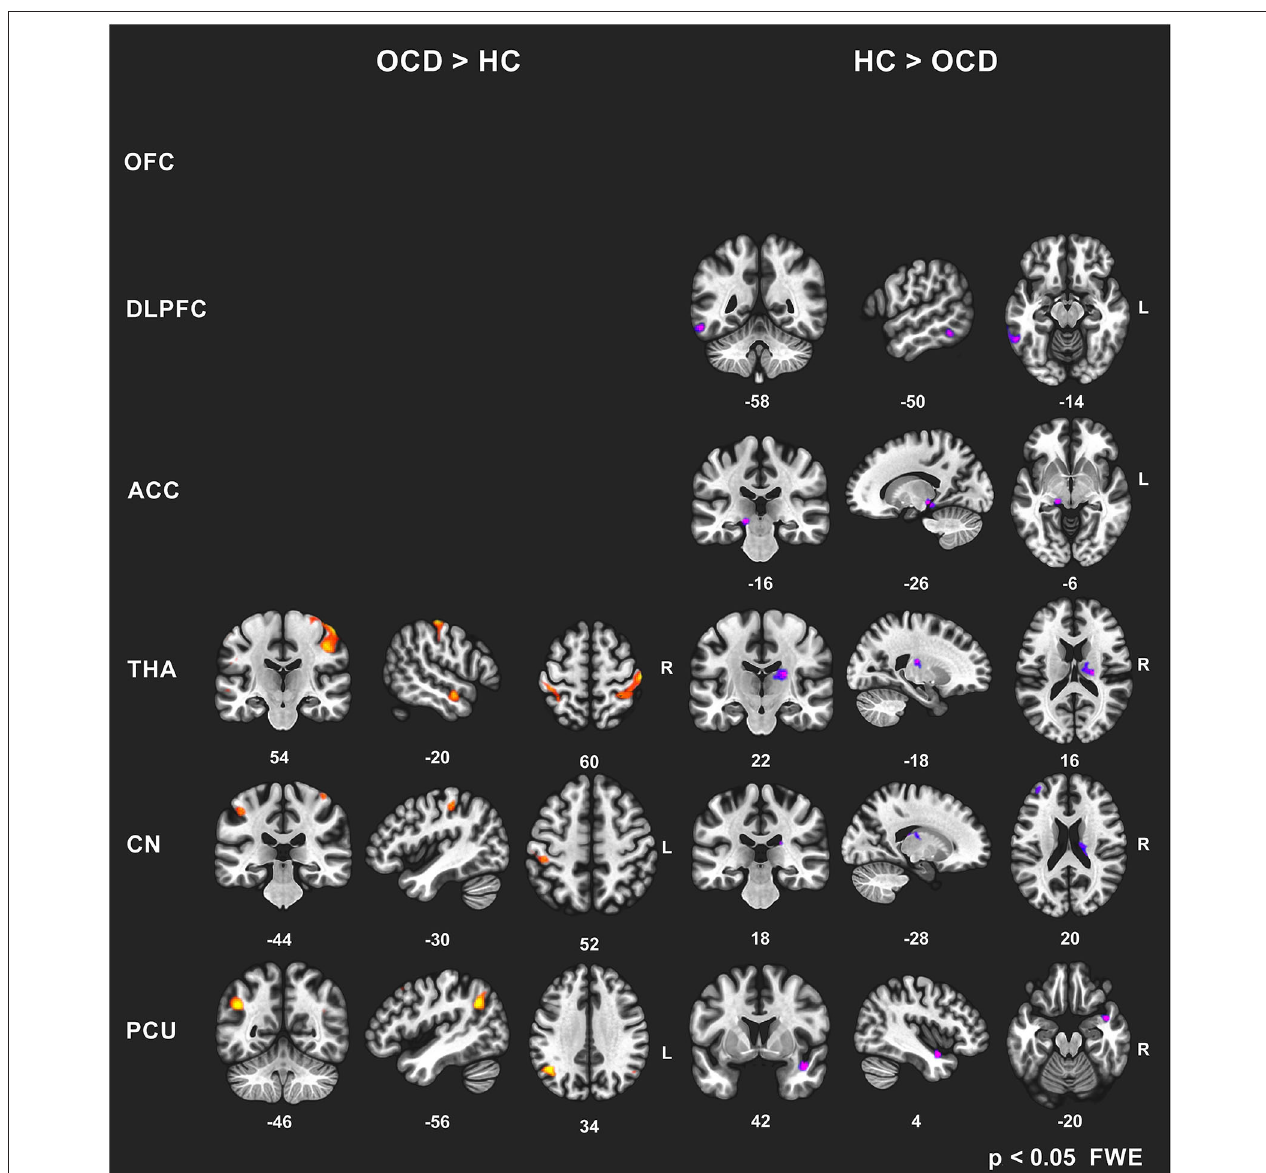
FIGURE 1 | Between-group comparisons of FC effects for individual seeds (brain slice display, FWE corr. p level 0.05, with cluster-forming threshold p < 0.001). Increased (OCD > HC) and decreased (HC > OCD) functional connectivity in OCD patients for six seeds (OFC—no effect found, DLPFC, ACC, THA, CN, PCU). The clusters obtained using the CONN toolbox are displayed in sagittal, coronal, and axial view in the x , y , z coordinates of the local maxima of the strongest cluster. OFC, orbitofrontal cortex; DLPFC, dorsolateral prefrontal cortex; ACC, anterior cingulate cortex; THA, thalamus; CN, caudate nucleus, PCU,